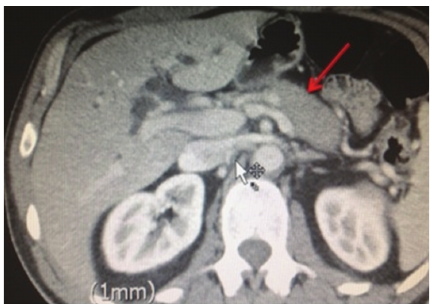
Figure 1: CT abdomen with “sausage-shaped”